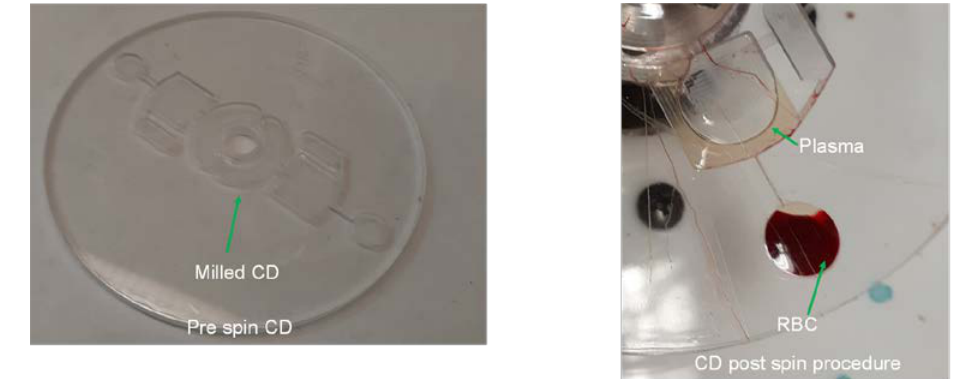
Figure 5. ( Left ) The image of the fabricated CD before the blood sample is loaded. ( Right ) The image of the part of the disc with RBC chamber and the reciprocation chamber after blood plasma separation has been performed—the red blood cells are all separated in the RBC chamber as is evidenced by the dark red color, while plasma only (transparent fluid) is present in the reciprocation chamber. The nitrocellulose membrane that is normally present in the reciprocation chamber has been removed to improve the clarity of the image.